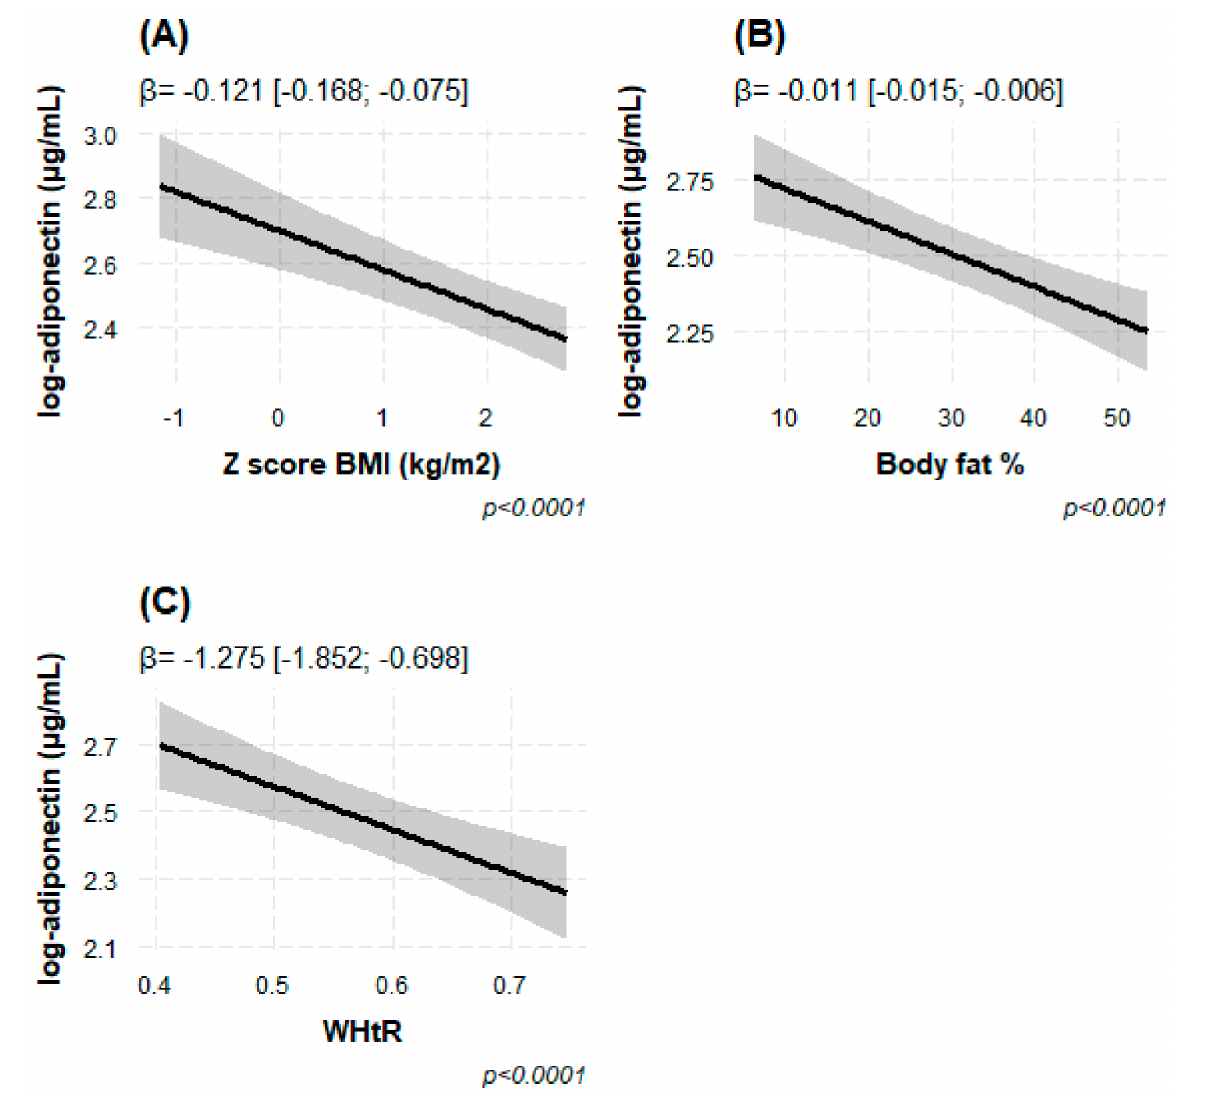
Figure 3. ( A – C ) Associations of circulating adiponectin concentrations in log − transformed µ g/mL, with several measures of overall and central adiposity. ( A ) BMI z-score, ( B ) total body fat % and ( C ) Waist to height ratio (WHtR). The statistical model was adjusted for age, sex, Tanner’s stage and FTO rs9939609 genotype. The results are expressed in beta effect estimates of and their respective 95%